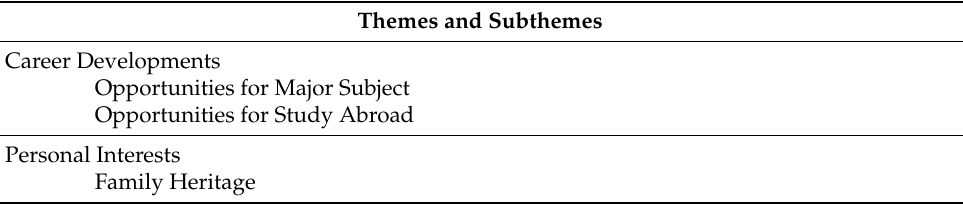
Table 1. Themes and subthemes of the